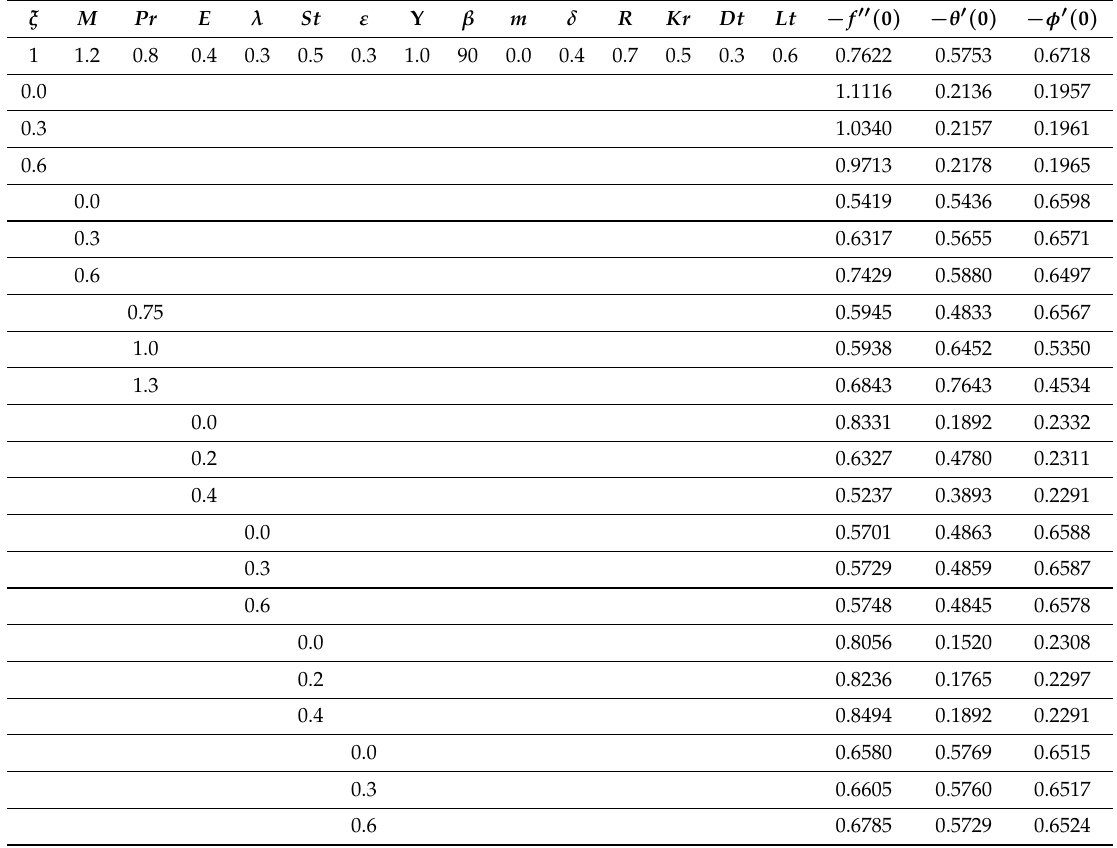
Figure 23. The temperature profile for distinct values of Lt . Table 2. Effects of A , M , Pr , λ , ε , Υ , δ , and β on − f (cid:48)(cid:48) ( 0 ) , − θ (cid:48) ( 0 ) and − φ (cid:48) ( 0 )